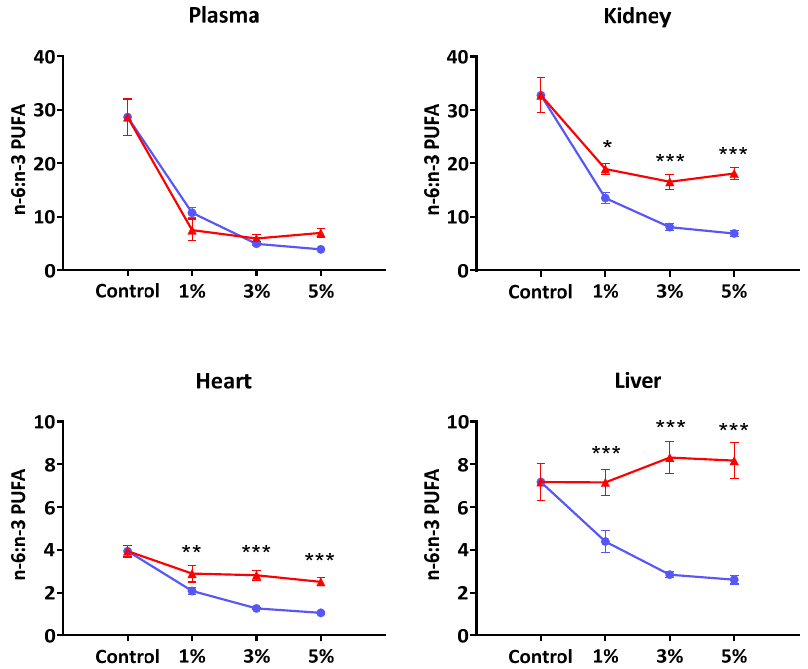
Figure 1. The ratio of total n ‐ 6 to total n ‐ 3 polyunsaturated fatty acids in tissue and plasma of rats fed standard laboratory diet (Control) or diet supplemented with Echium oil (EO, red ) or fish oil (FO, blue ) at 1, 3 and 5 percent ( w / w ). Values are mean ± SEM for n = 5 samples per group. Total n ‐ 3 PUFA = Sum (C18:3 n ‐ 3, C18:4 n ‐ 3, C20:5 n ‐ 3, C22:5 n ‐ 3 and C22:6 n ‐ 3). Total n ‐ 6 PUFA = Sum (C18:2 n ‐ 6, C20:2 n ‐ 6, C20:3 n -6 & C20:4 n -6). * , ** , and *** indicate significance at p < 0.05, p < 0.01 and p < 0.001,